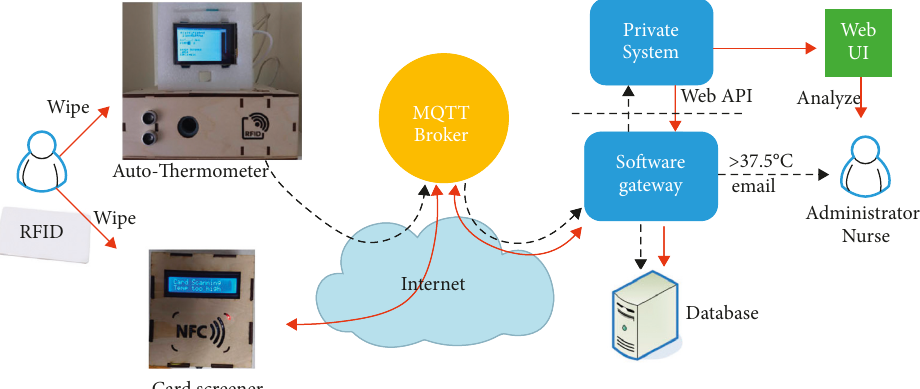
Figure 1: Overall system architecture, including two types of hardware devices and a software gateway.